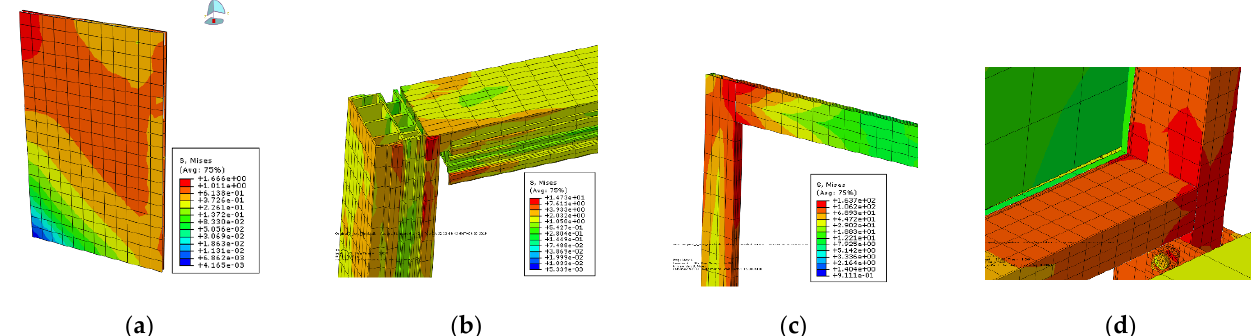
Figure 20. Stress distribution in each member of non-seismic curtain wall during X -axis drift: ( a ) glass; ( b ) mullion-to- transom; ( c ) PVC; ( d ) aluminum-to-glass.